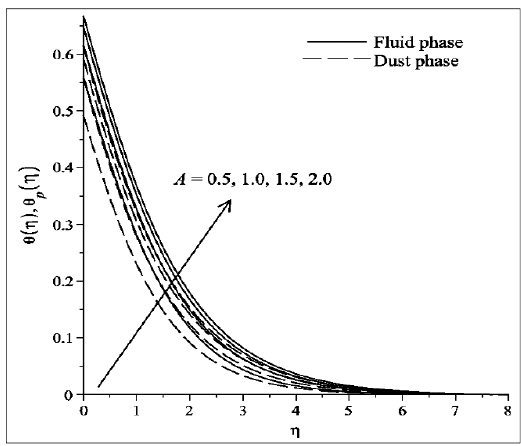
A A A Figure 7. Profile on temperature for various A